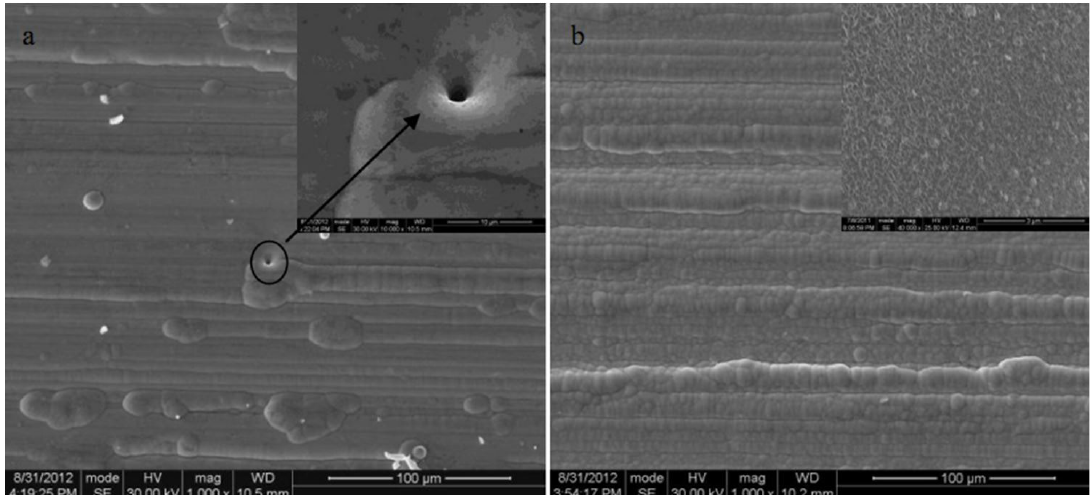
Figure 3. Surface SEM images of Ni coatings. (a) ordinary Ni coating. (b) multilayered Ni